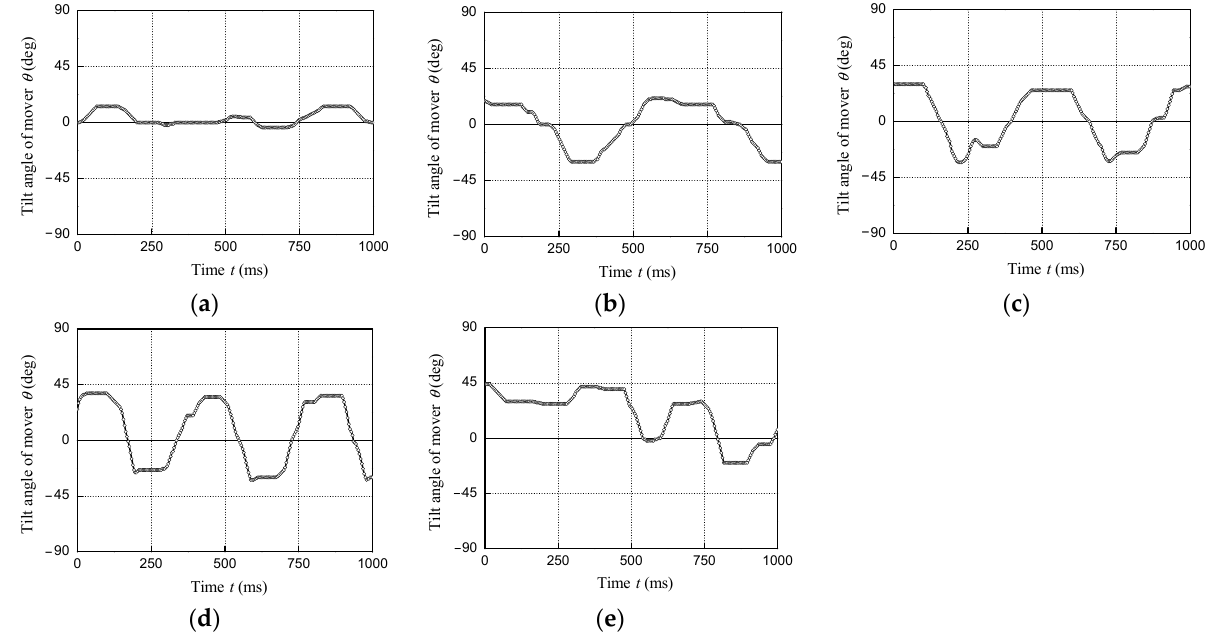
Figure 13. Vibration-experiment result at θ m = 45°. ( a ) f i = 1.0 Hz; ( b ) f i = 1.5 Hz; ( c ) f i = 2.0 Hz; ( d ) f i = 2.5 Hz; ( e ) f i = 3.0 Hz.